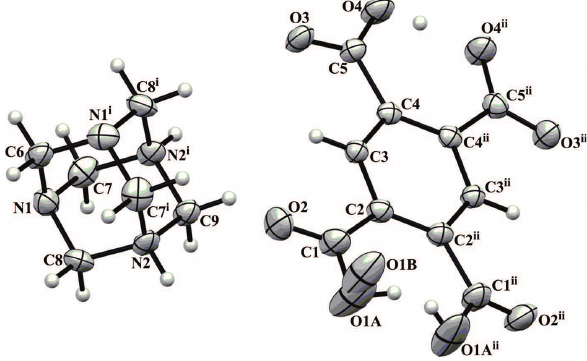
Table 1: Data collection and handling.